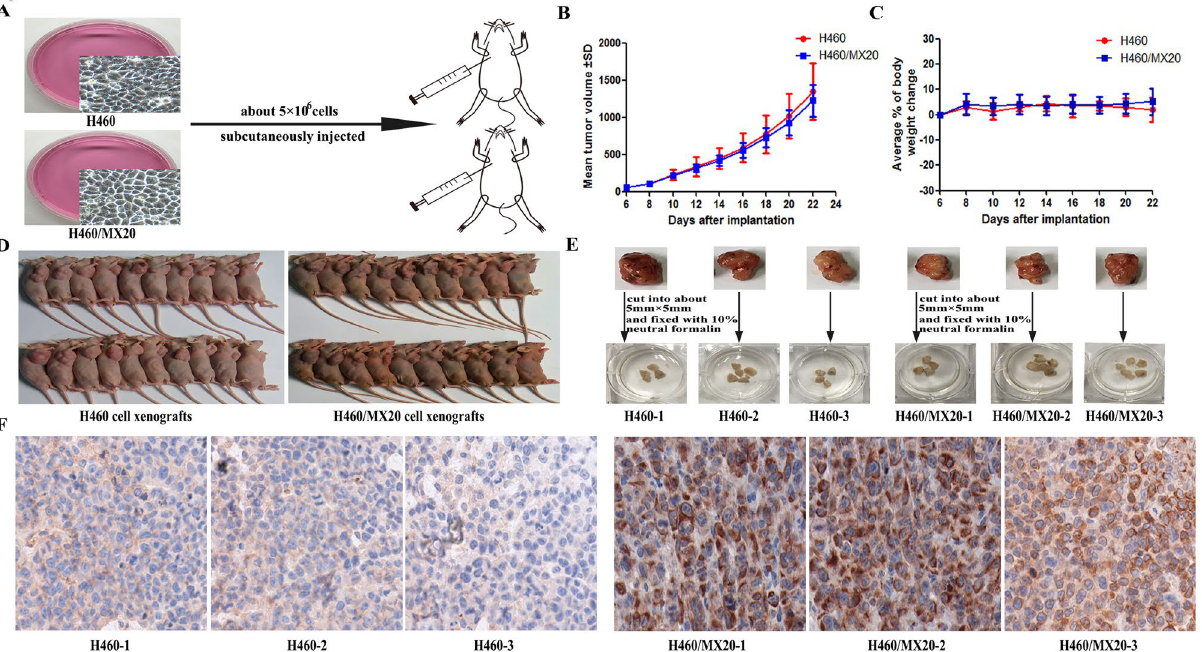
Figure 1. ( A ) A total of 40 mice were subcutaneously inoculated with H460 and H460/MX20 cells (≈ 5 × 10 6 ) in the right flank, respectively. ( B , C ) The changes in tumor volume and body weight over time following the implantation. Data points represented the mean ± SD of tumor volumes and body weight from each group. n = 20. ( D ) Solid tumor formation rate of H460 and H460/MX20 cells (100%). ( E ) The selected cell xenografts were cut into about 5 mm × 5 mm and fixed with 10% neutral formalin. ( F ) ABCG2 expression analysis by immunohistochemistry in tumor tissues collected from H460 and H460/MX20 cell